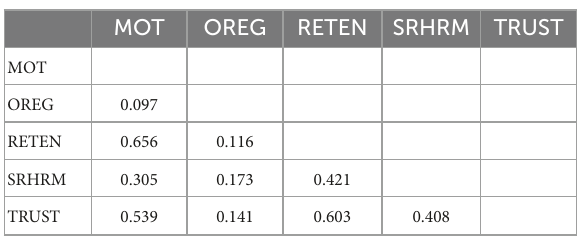
TABLE 4 Heterotrait–Monotrait ratio of correlations (HTMT) results.